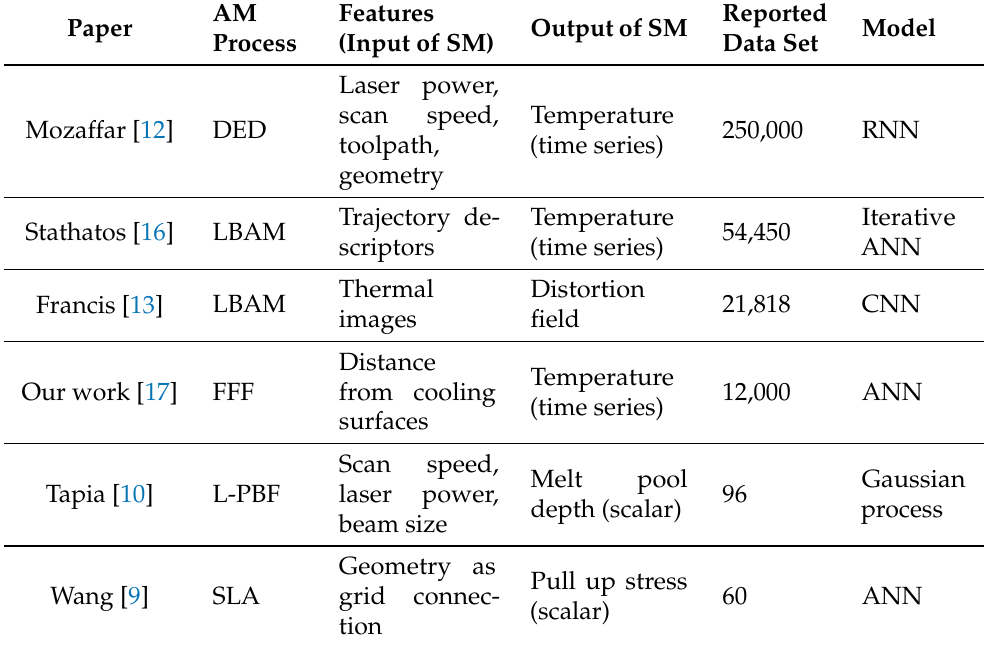
Table 1. Current state-of-the-art surrogate models in additive manufacturing.